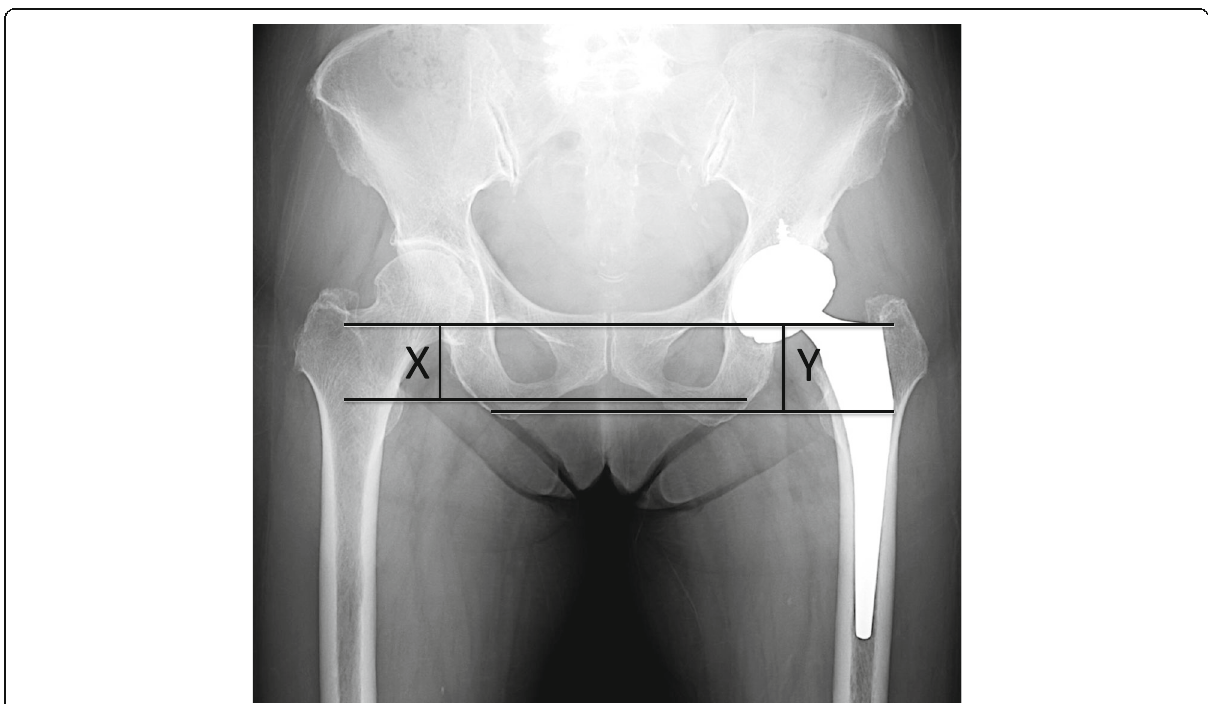
Fig. 3 The distance between a line passing through the lower edge of the teardrop to the tip of the lesser trochanter of the operated (X) and the non-operated hip (Y) were measured. The difference of the each side (X-Y) was defined as the LLD